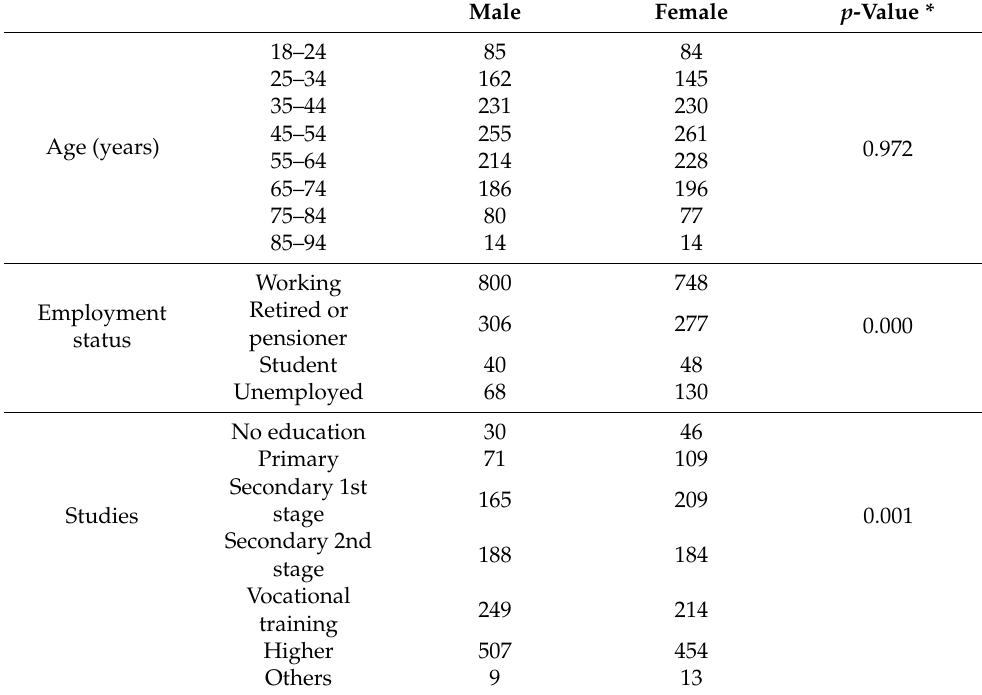
Table 1. Analysis of sociodemographic